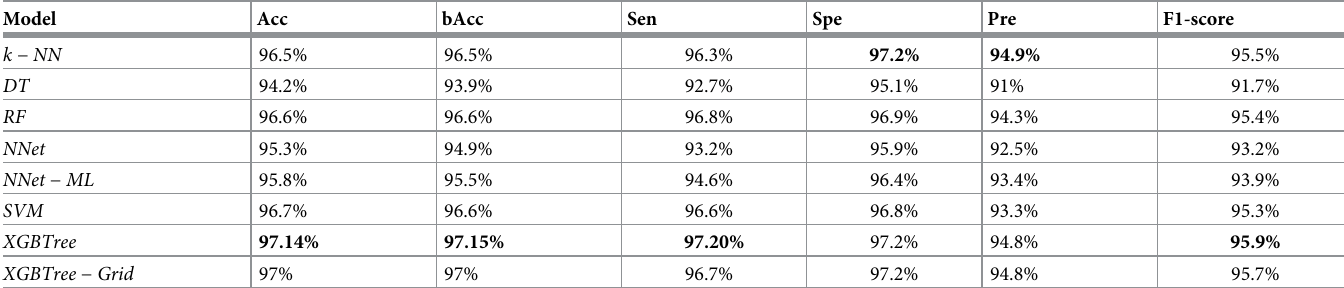
Table 3. Average prediction performance of the models.